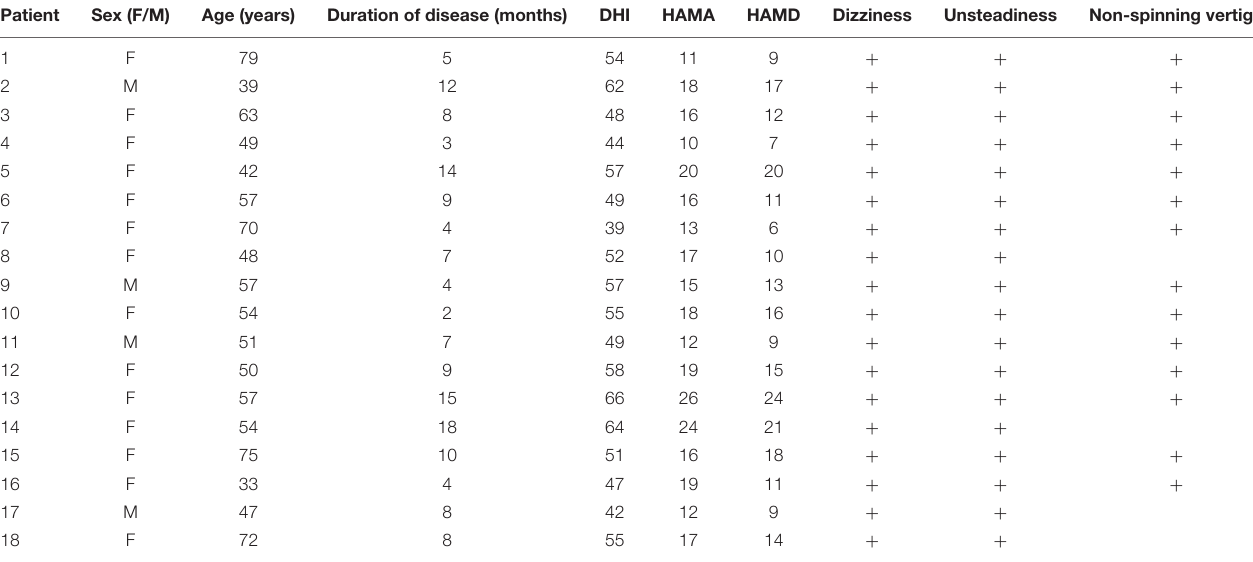
TABLE 1 | Characteristics of the patients with PPPD.